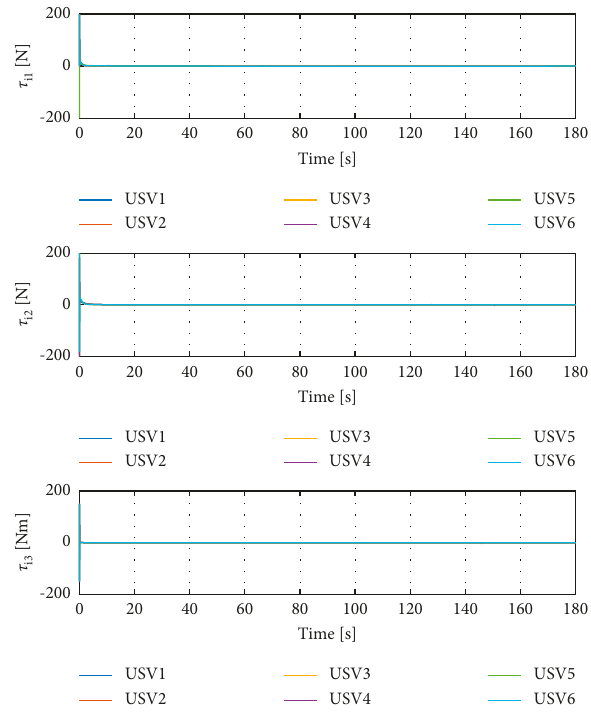
Figure 11: The control input ( τ